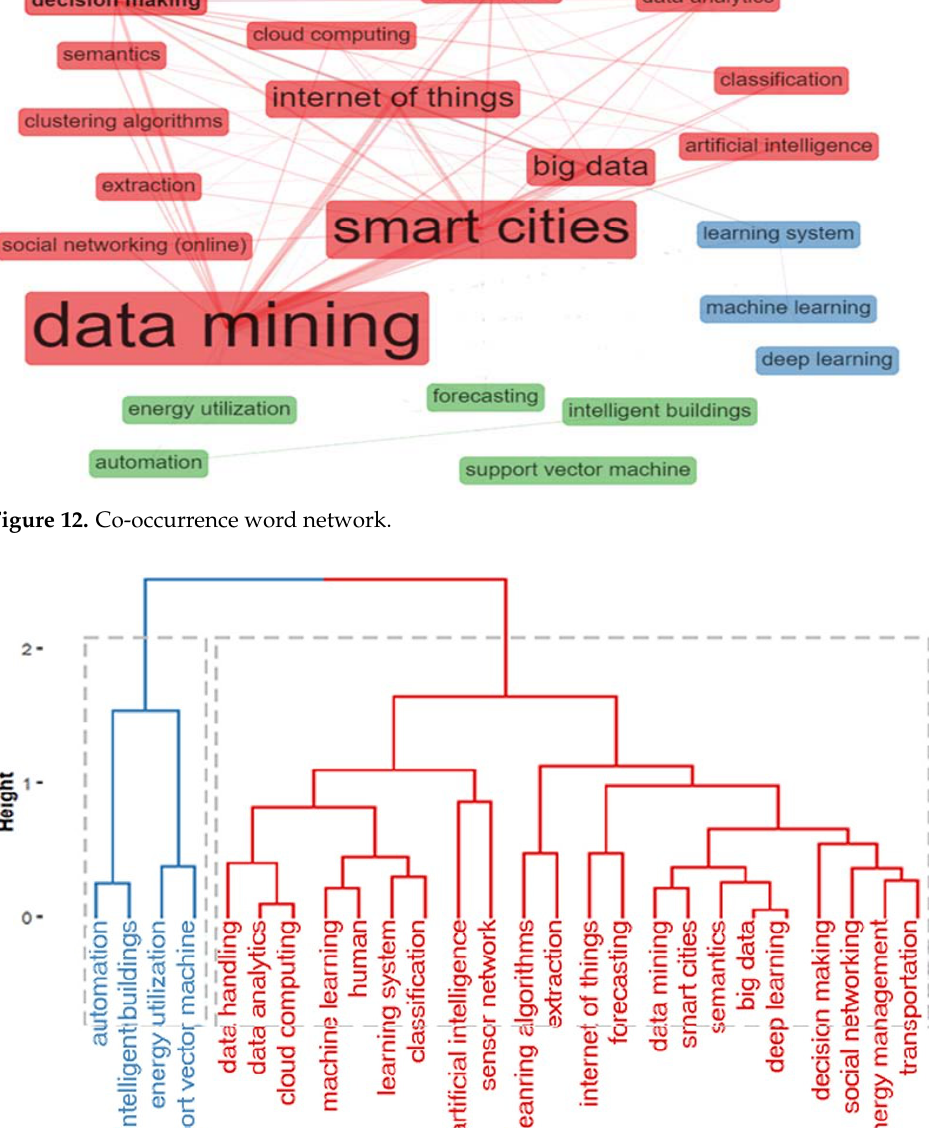
Figure 13. Topic dendrogram.